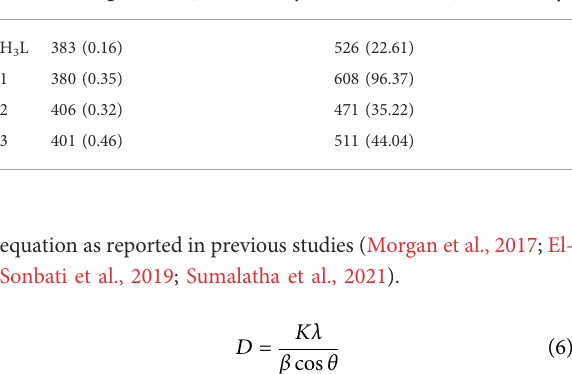
TABLE3TheemissiondataoffreeligandwithitsZn(II),Cu(II)andNi(II) complexes. Absorption λ max (Intensity) Emission λ max